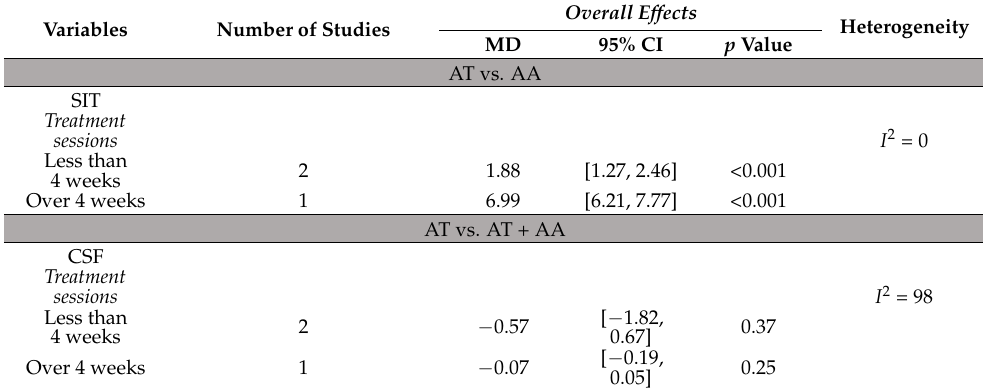
Table 3. Sensitive